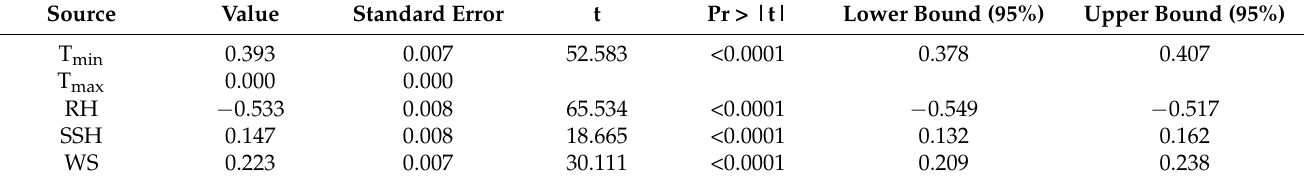
Table 6. The regression analysis for identifying the most effective parameters for evaporation estimation at the Ludhiana station.